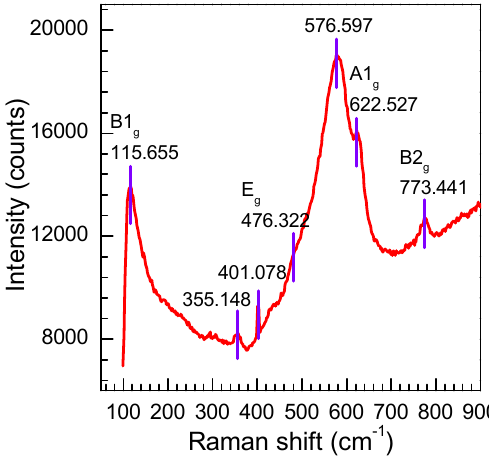
Figure 6. Raman scattering spectrum of the SnO 2 nanosheets.